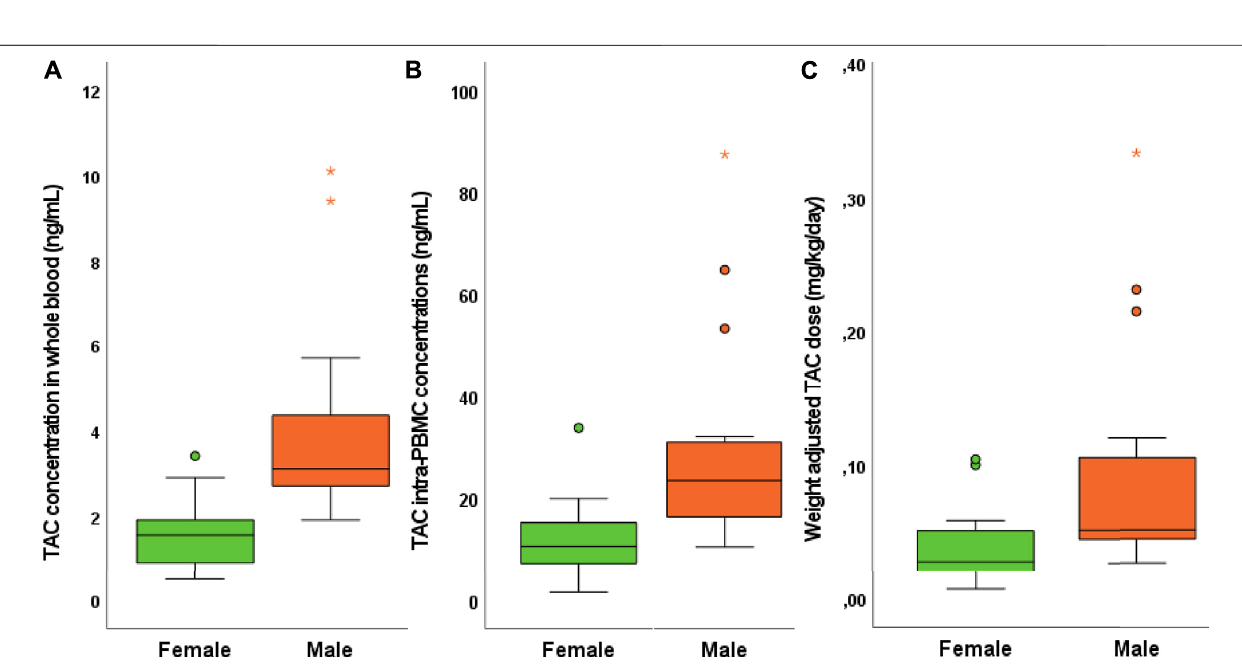
Frontiers in Pharmacology |